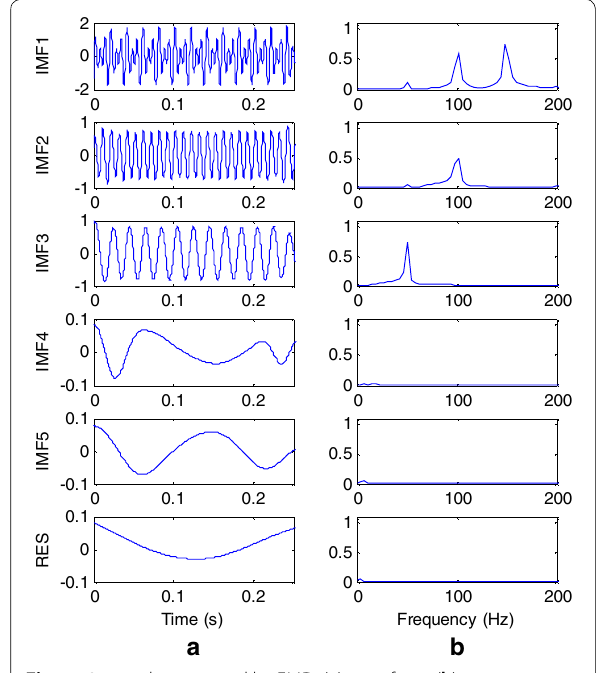
Figure 2 x ( t ) decomposed by EMD: ( a ) waveform; ( b ) amplitude-frequency